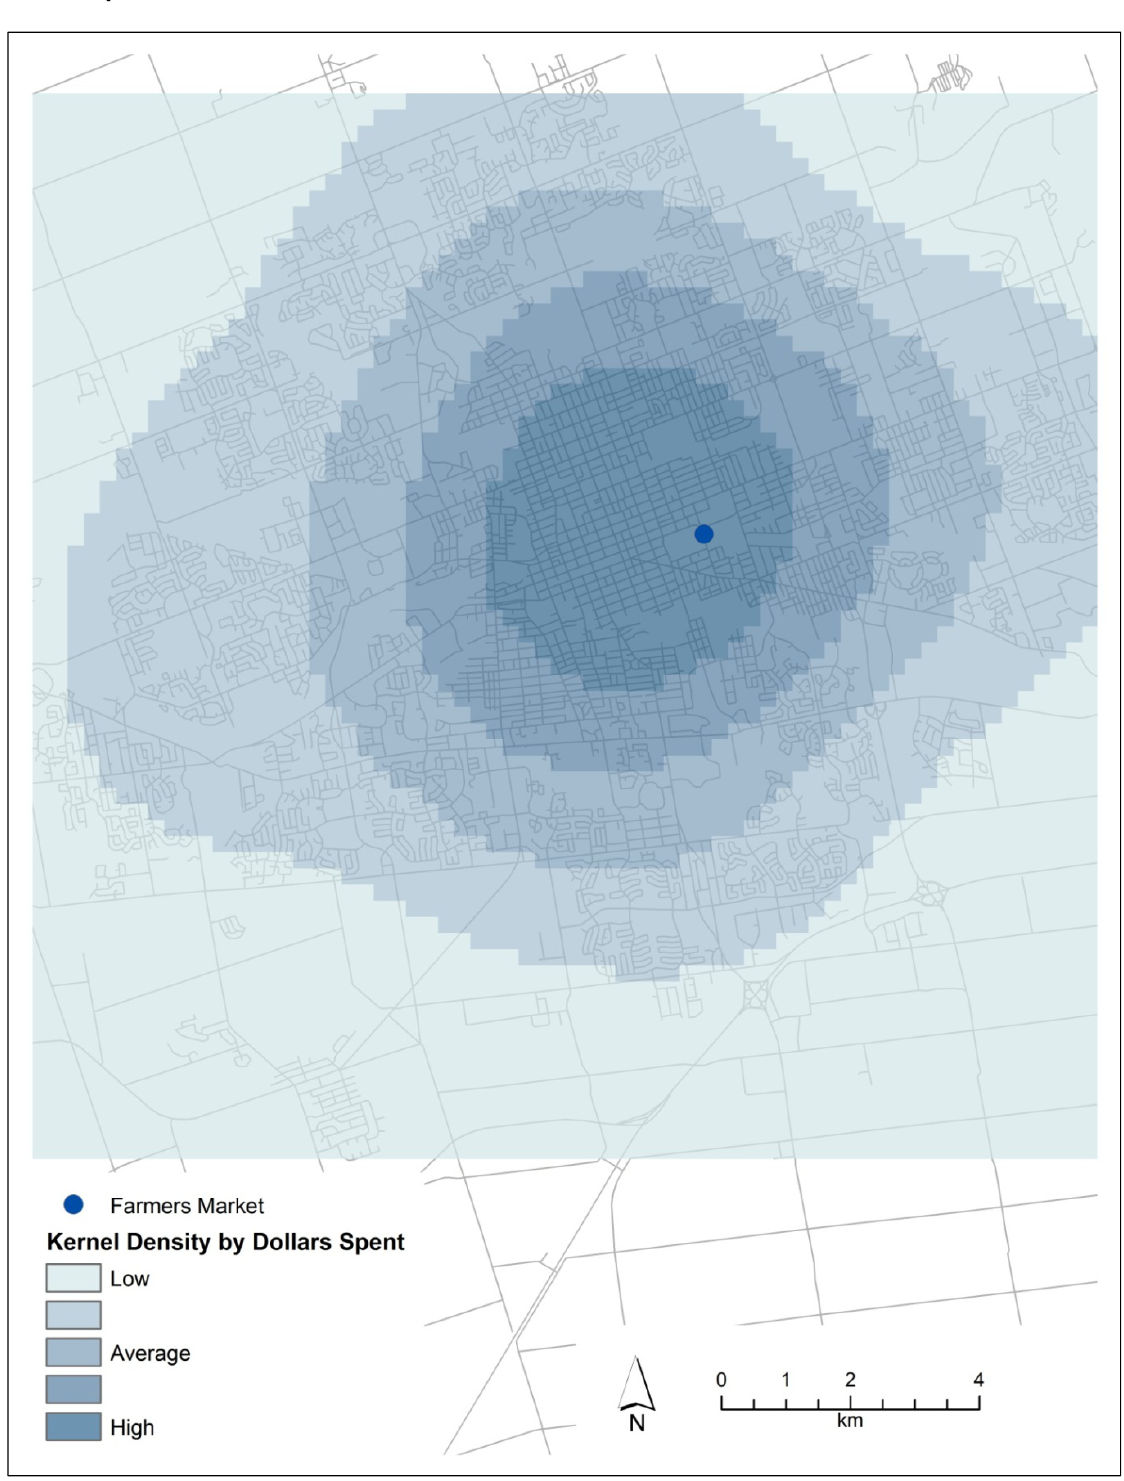
Figure 4. Kernel Density of Western Fair Farmers’ and Artisans’ Market Customers Weighted by Dollars